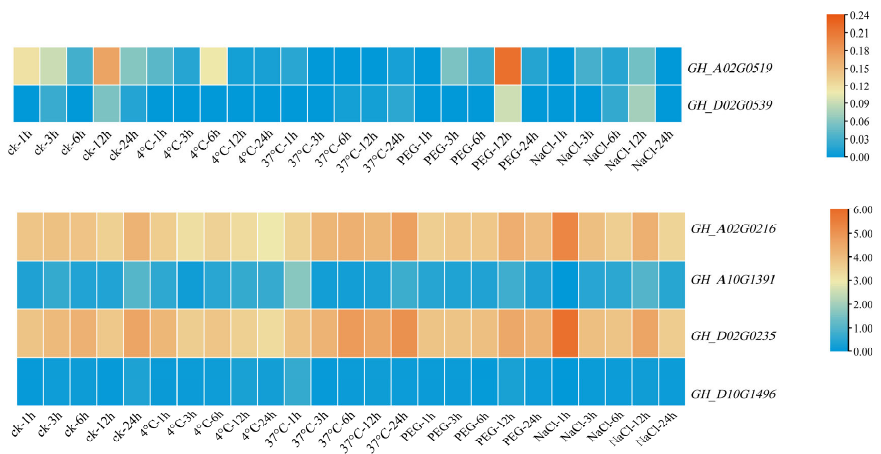
Figure 8. Expression pattern of Filamin gene family members under abiotic stresses of G. hirsutum.